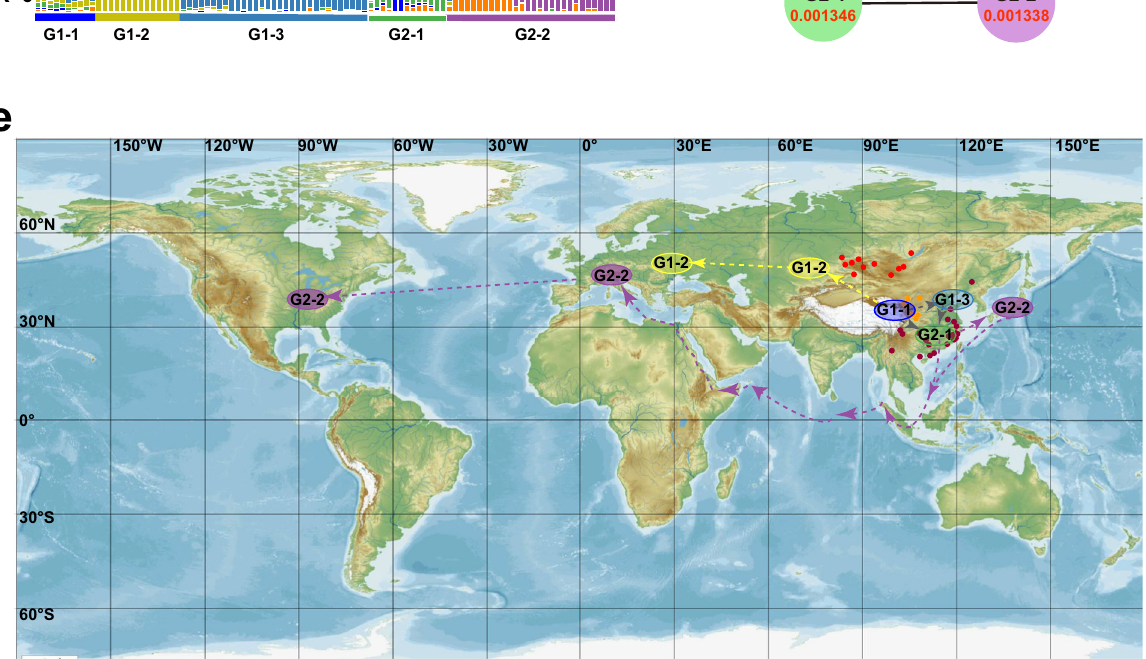
the fi vesubgroups.Thenumbersinredfontwere π valuesandthenumbersinblue font were Fst values. e The possible migration routes for bunching onion (the map was downloaded from Mapswire, https://mapswire.com/world/physical-maps/). The dots indicated the habitat of the close relatives of A. fi stulosum